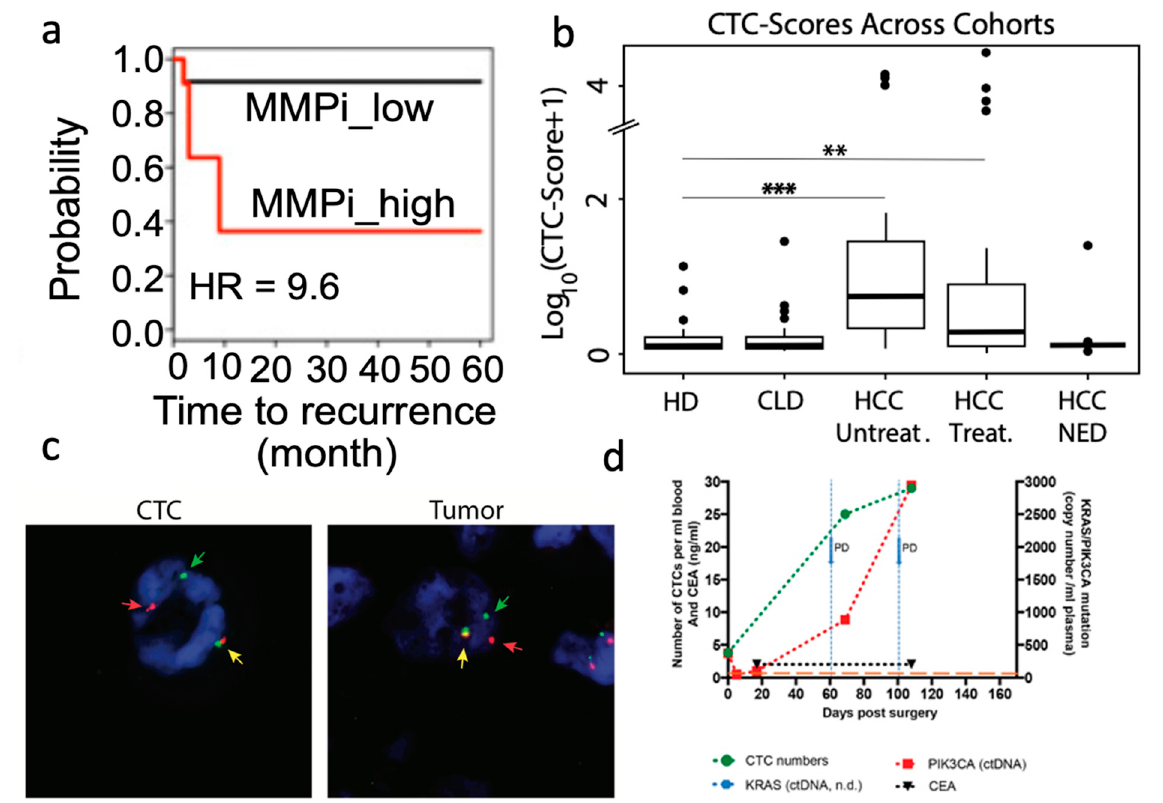
Figure 3. IM CTC purification enables analyses directly beneficial for improving cancer patient health. ( a ) Kaplan–Meier survival curves associated with the MMPi model derived from CTC transcriptomics depict patient likelihood for recurrence-free survival. Reprinted from [31]; permission conveyed through CC BY-NC-ND 4.0. ( b ) Box plot depicting patients with the active disease having higher CTC scores compared to healthy donors (HD), those with chronic lung disease (CLD), and those with no evidence of disease (NED). Reprinted with permission from [34]. ( c ) Break-apart FISH probes revealed identical ALK rearrangements in an NSCLC patient’s CTCs and surgical tumor biopsy. Reprinted from [36]; permission conveyed through CC BY 3.0. ( d ) A longitudinal study of the patient following treatment revealed elevated CTC count and ctDNA mutation copies following evidence of progressive disease (PD). Reprinted from [37]; permission conveyed through CC BY 3.0.